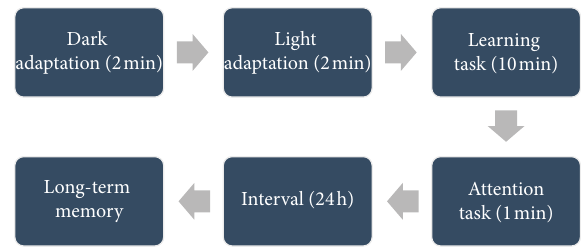
Figure 5: Experimental procedure. Table 1: Descriptive statistics of attention and long-term memory according to illuminance of LED lighting.